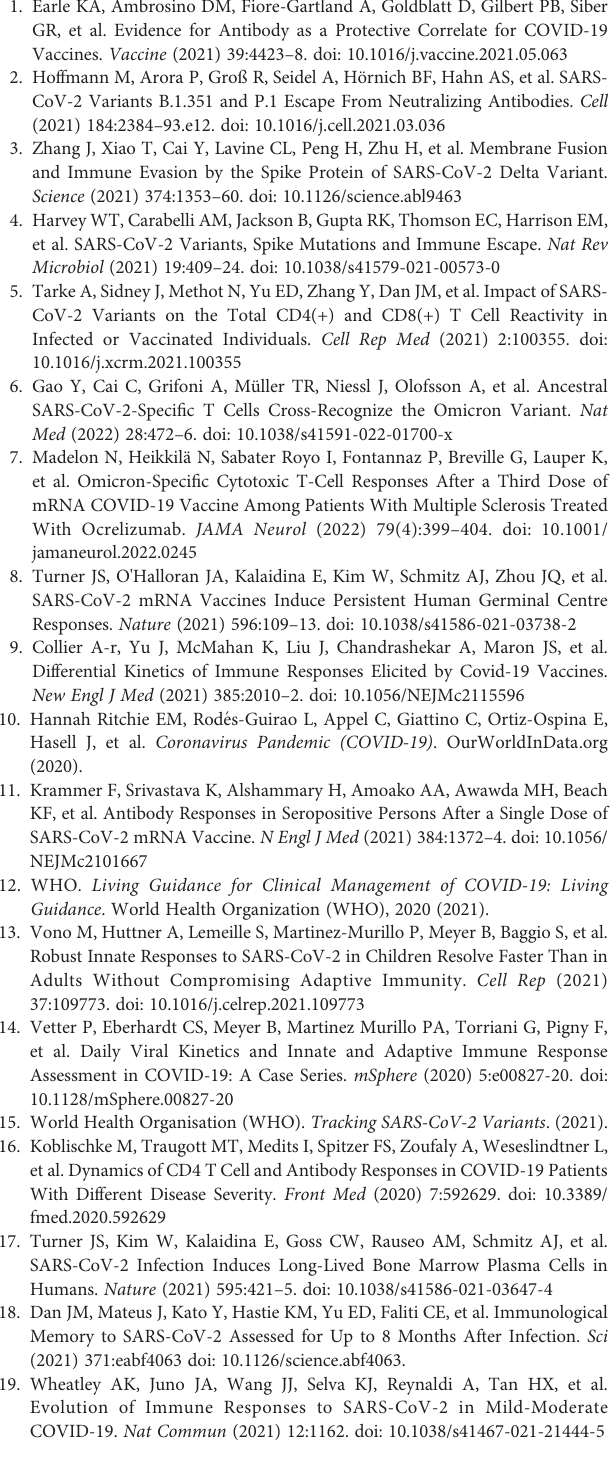
neutralizing antibody titres of all available paired serum samples at 6 months and one-year post onset of symptoms for SARS-CoV-2 WT and variants. Paired samples, i.e. from the same patient are connected with black